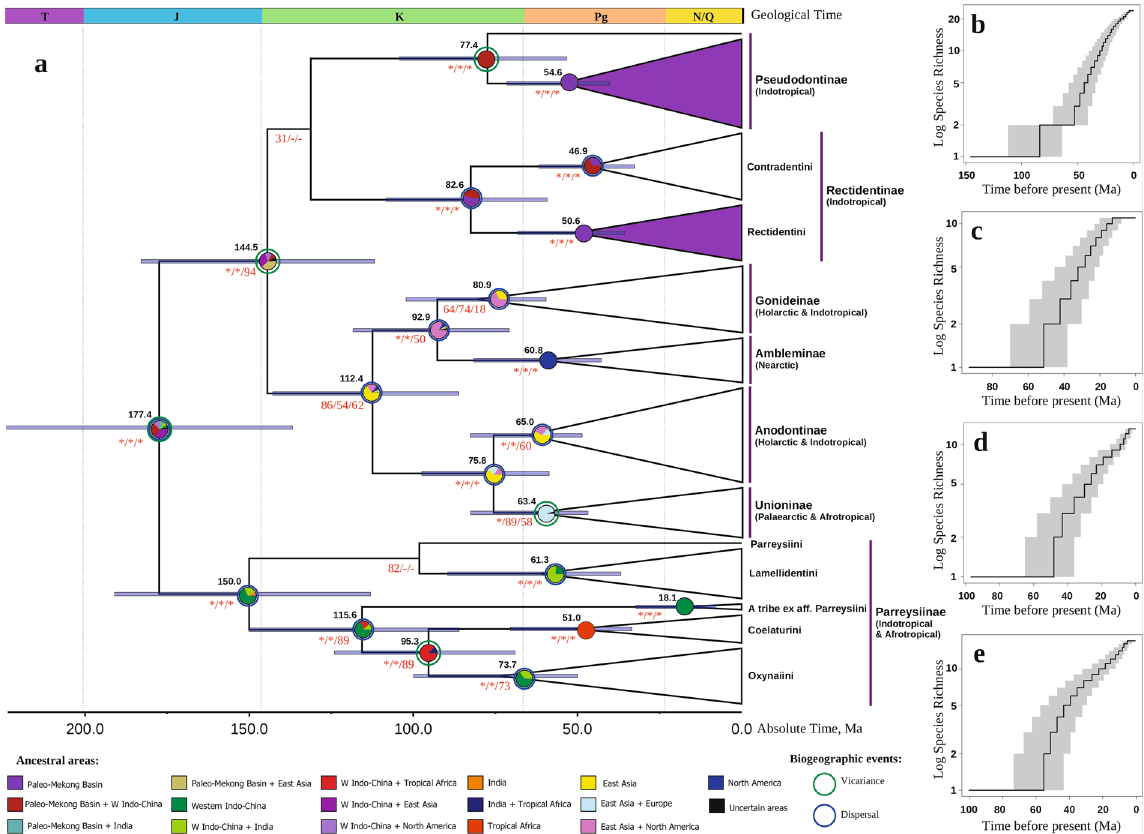
Figure 1. Multi-locus fossil-calibrated phylogeny, ancestral area reconstruction and diversification of the Unionidae. ( a ) Biogeography and divergence times of the primary clades of the Unionidae inferred from statistical analyses based on the fossil-calibrated ultrametric chronogram calculated under a lognormal relaxed clock model and a Yule process speciation implemented in BEAST 1.8.3 and obtained for the complete data set of mitochondrial and nuclear sequences (five partitions: three codons of COI + 16S rRNA + 28S rDNA). Pie chaps near nodes indicate the probabilities of certain ancestral areas with respect to combined results under three different modeling approaches (S-DIVA, DEC and S-DEC). The violet filling of collapsed nodes indicates the two ancient bivalve radiations within the Paleo-Mekong drainage basin. Black numbers near nodes are the mean age values, and bars are 95% confidence intervals of the estimated divergence time between lineages (Ma). Red numbers near nodes are BPP values inferred from BEAST, BPP values inferred from MrBayes and BS values inferred from RAxML (an asterisk indicates BPP and BS values of ≥ 95%; and “-” indicates a topological difference). The ancestral area reconstruction and timing of doubtful nodes, the position of which differs in different analyses, are omitted. Stratigraphic chart according to the International Commission on Stratigraphy, 2015. The full variants of the chronogram and ancestral area reconstructions are presented in Supplementary Figs 4 and 5. The list of sequences is presented in Supplementary Table 1. ( b – e ) Semilogarithmic lineage- through-time (LTT) median plots of chronograms estimated from 36,004 post-burn-in Bayesian trees for several endemic Indo-Chinese clades, including ( b ) Rectidentinae, ( c ) Rectidentini (a paleo-Mekong clade), ( d ) Contradentini, and ( e ) Pseudodontinae (a paleo-Mekong clade). The gray filling indicates 95% confidence